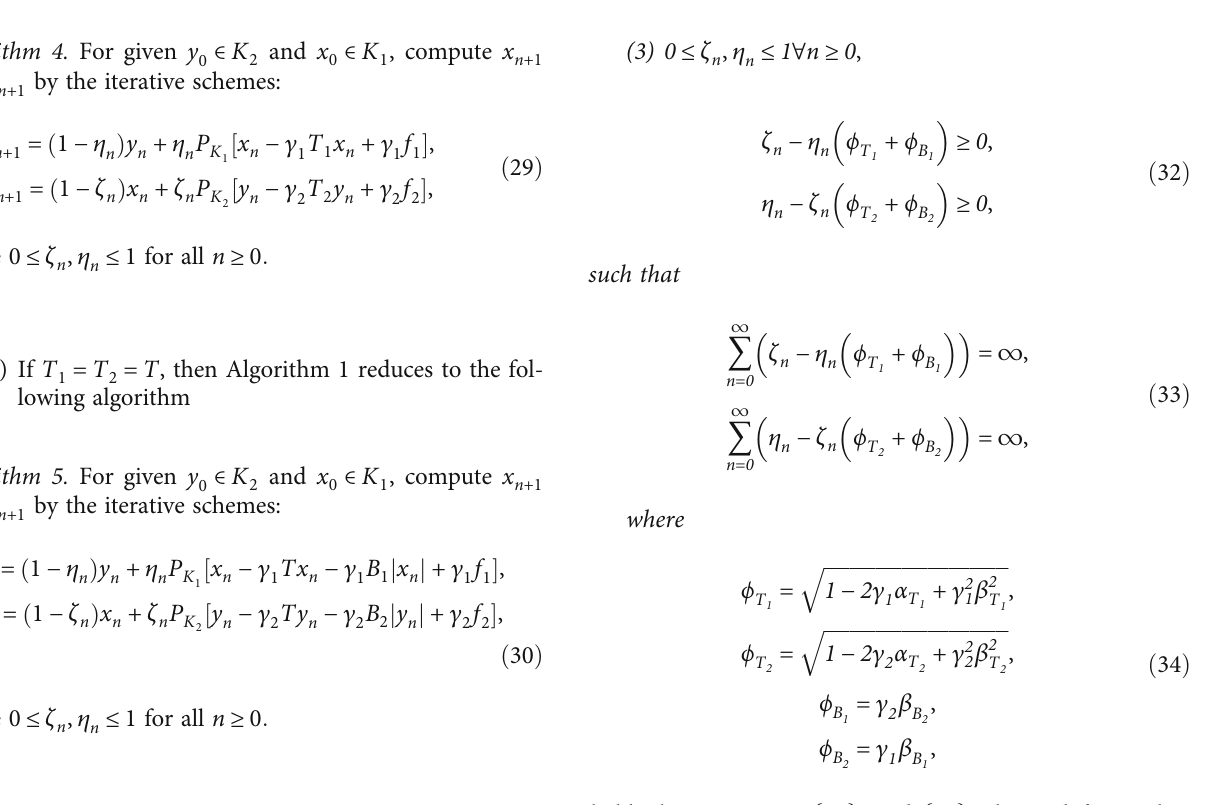
Algorithm 6. For given y 0 ∈ K 2 and x 0 ∈ K 1 , compute x n